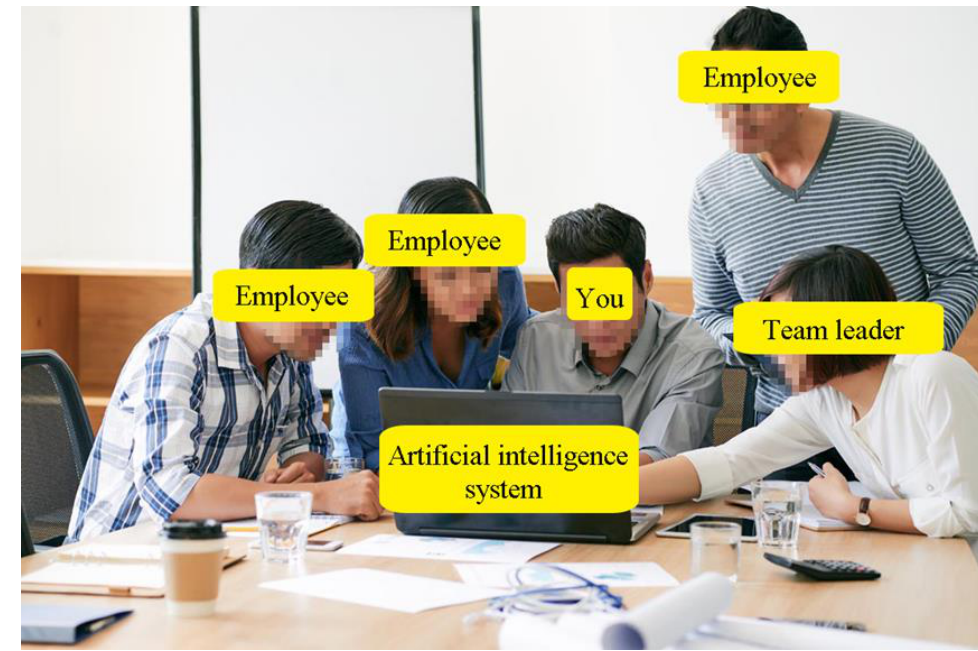
Figure A1. Employees interacting with the AI system used in study.